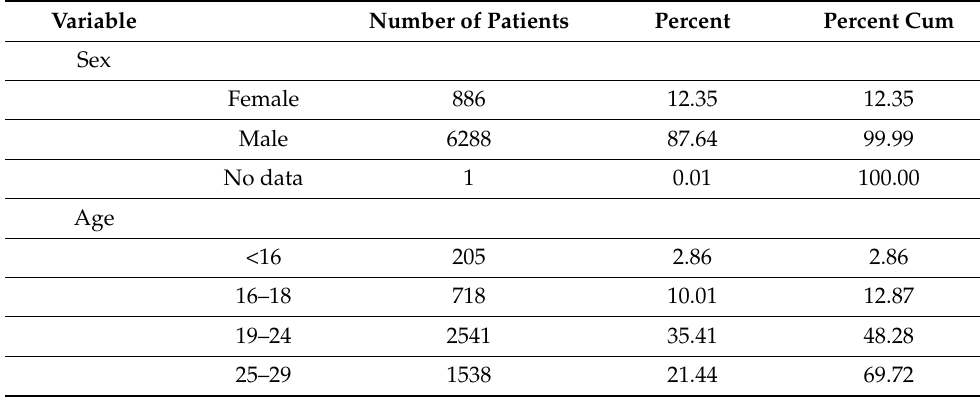
Table 2. The characteristics of patients in terms of their sociodemographic features and the character- istics of intoxications based on the analysed variables.